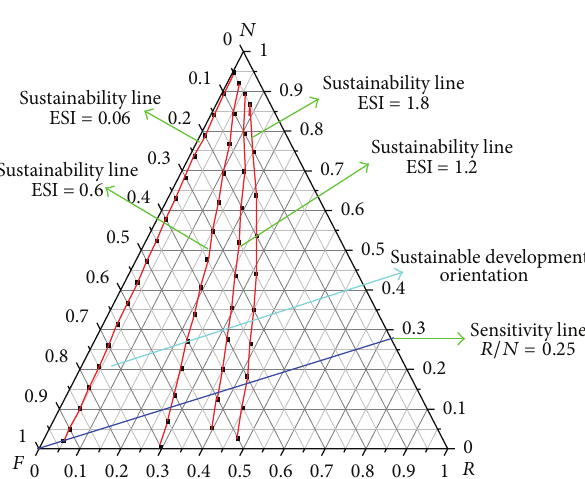
Figure 3: Sustainability line in emergetic ternary diagram.